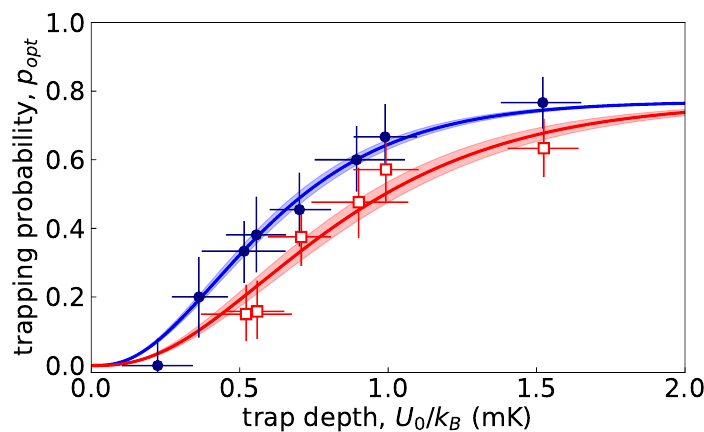
Figure 3. Sympathetic cooling of a Ba + ion in a cloud of ultracold Rb atoms. Open squares: experi- mental data taken after placing the ion in the bichromatic trap in absence of atoms. A fit with a modi- fied radial-cutoff model[32] to the data (lower solid line) yields a temperature of T Ba + Full circles: the same experiment carried out with atoms, yielding T Ba + symp = 259 ± 10 µ K (upper solid line). From Schmidt, Weckesser, Thielemann, Schaetz, and Karpa (2020)